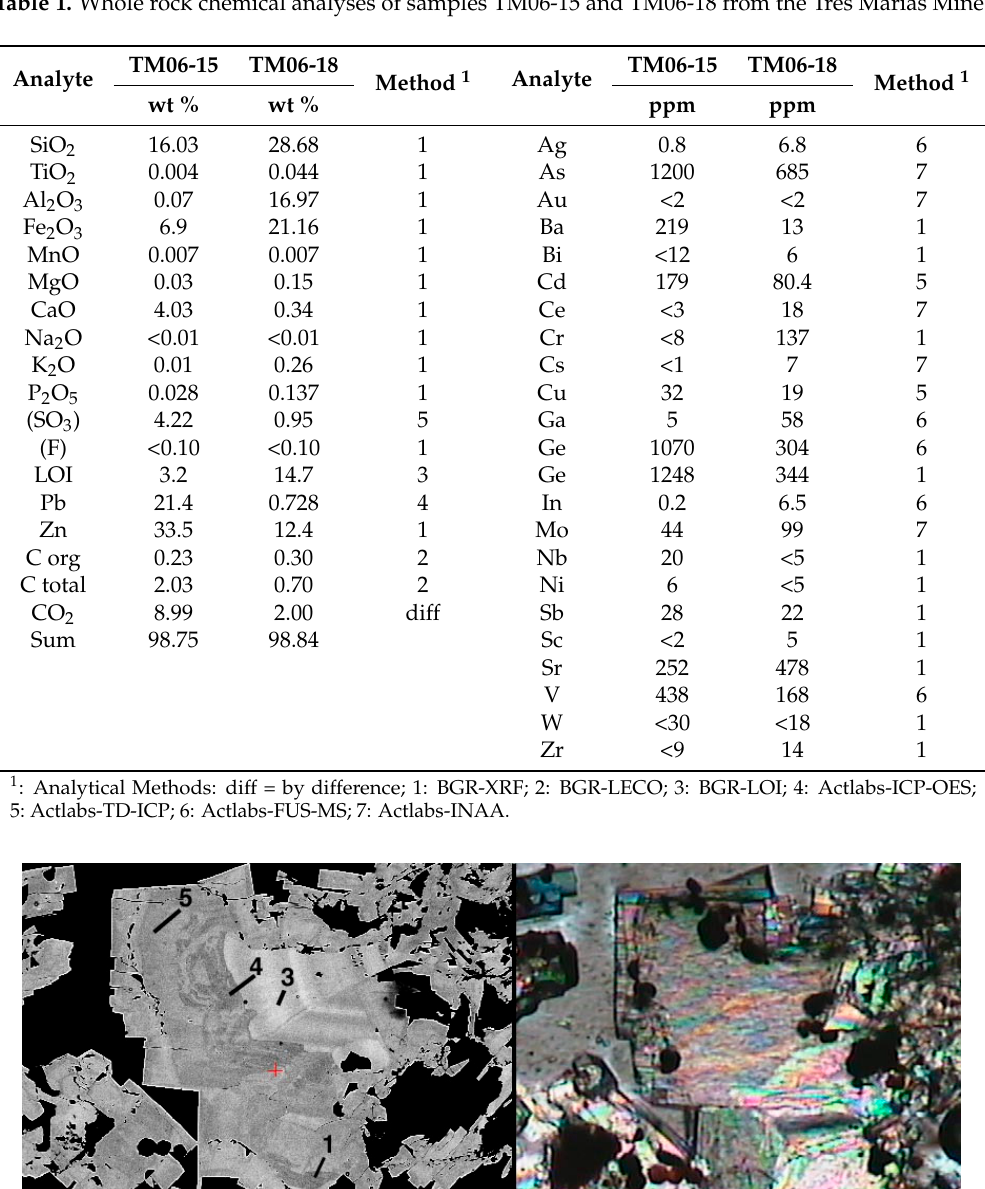
Table 1. Whole rock chemical analyses of samples TM06-15 and TM06-18 from the Tres Marias Mine. Analyte